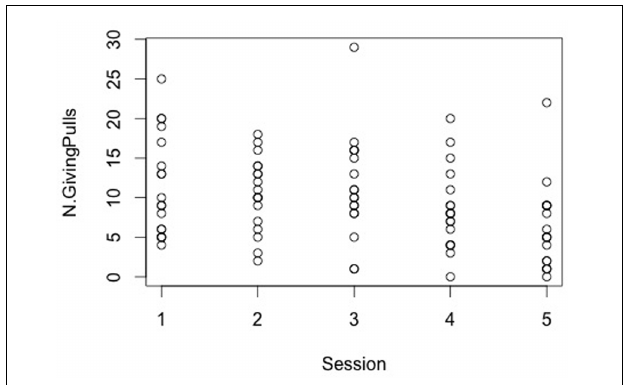
FIGURE 3 | The number of giving pulls decreases across session (likelihood ratio test: χ 2 = 21.71; p < 0.001).